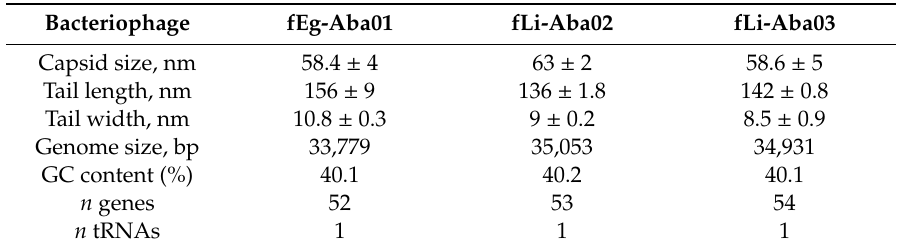
Table 1. Phage particle and genome overview. Phage dimensions were measured by TEM and represent mean values for at least 10 measured phage particles.